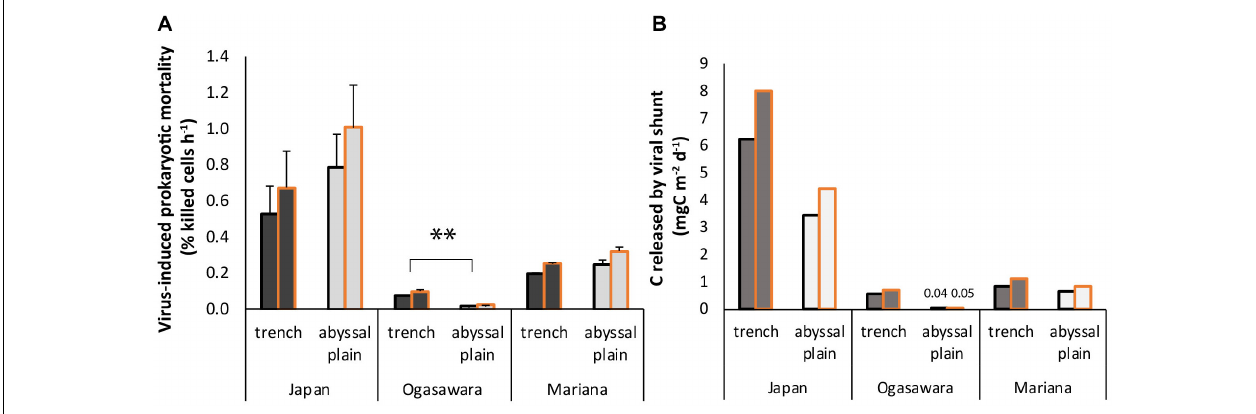
FIGURE 6 | (A) Virus-induced prokaryotic mortality (VIPM). Reported are the mean values using two different burst sizes (BS), 45 (black contour) and 35 (gold contour), respectively (Danovaro et al., 2008b, 2016), and related SDs for each hadal trench site and related abyssal site. Statistical significance is tested between hadal trench and abyssal sites. ∗∗ p < 0.01. (B) C released by killed prokaryotes due to viral lysis. Reported are the value per each hadal trench site and related abyssal sites obtained by using two different burst sizes (BS), 45 (black contour), and 35 (gold contour),